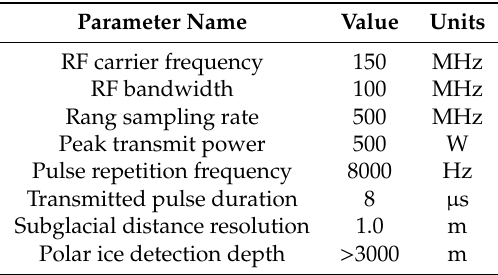
Table 1. The main technical parameters of deep ice-penetrating radar (IPR). The abbreviation of RF is repetition frequency